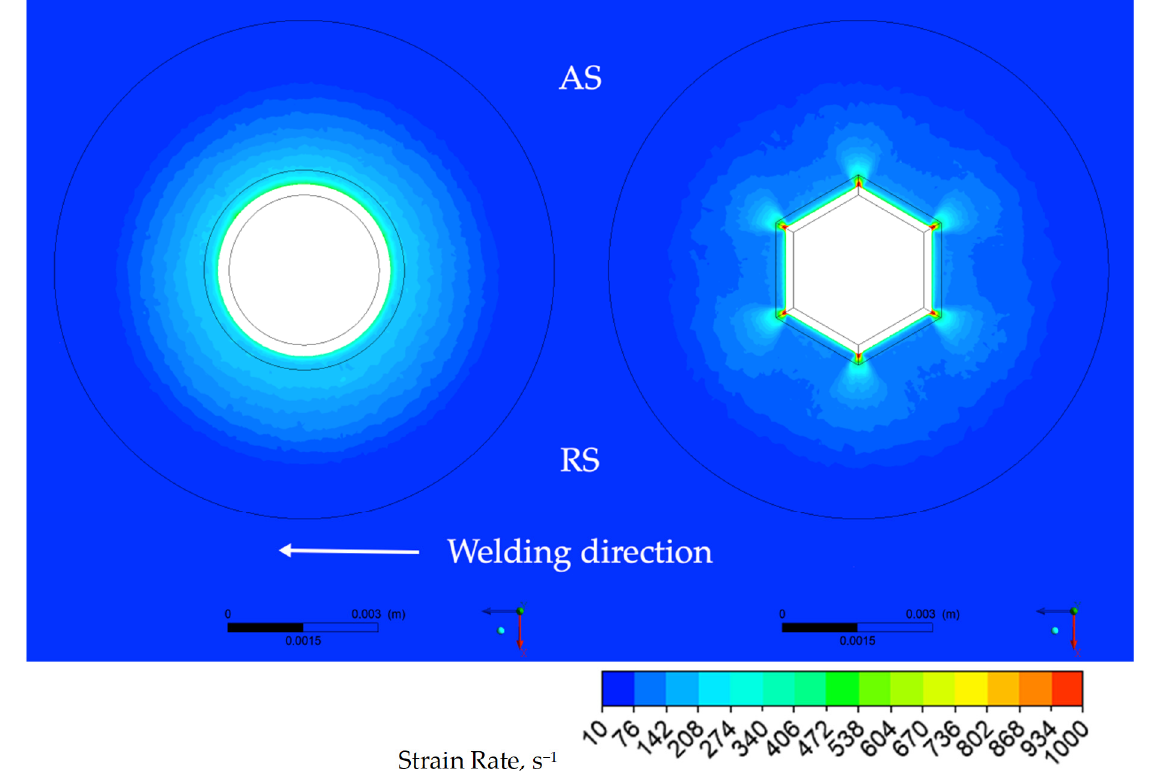
Figure 13. The distribution of the strain rate in the plane of the welded sheets at a distance of half of the thickness for both samples, FSW − C ( left ) and FSW − H ( right ).